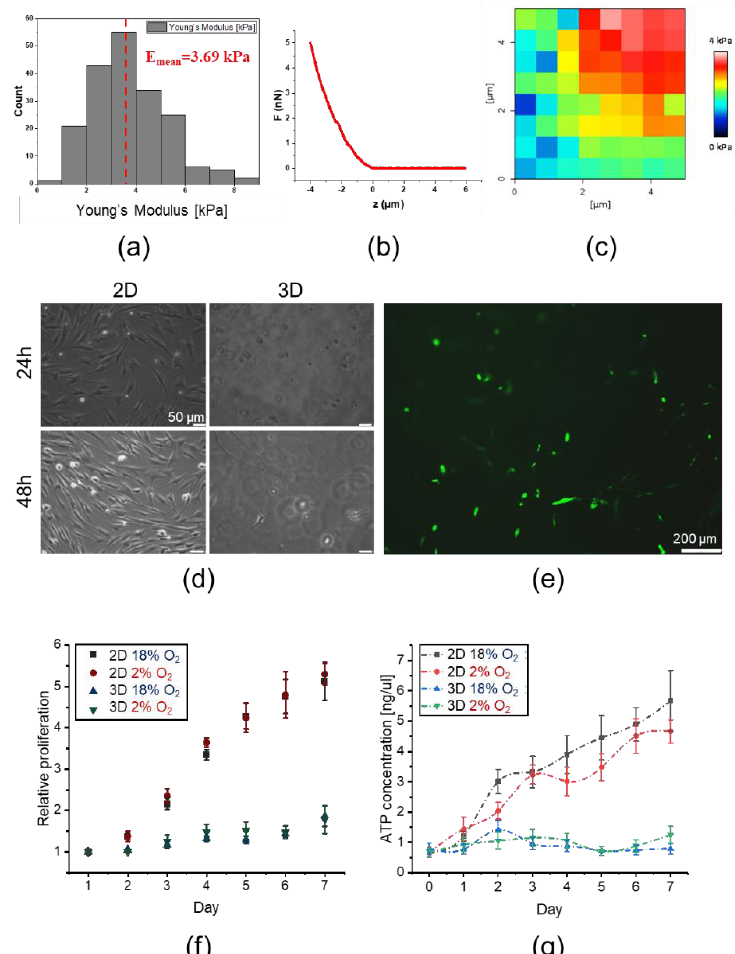
Figure 7. Mechanical properties of the hydrogel matrix and their impact on morphology, proliferation, and metabolic activity of DPSCs. ( a ) Young’s modulus distributions of hydrogel matrix by AFM. ( b ) Exemplary force curve recorded on the hydrogel. ( c ) Exemplary elasticity map of peptide hydrogel. ( d ) Morphology of DPSCs encapsulated in hydrogel (3D) or seeded on the surfaces coated with gelatin (2D) at 24 and 48 h post-seeding. DPSCs were cultured in DMEM / F12 supplemented with 10% FBS and cultured under standard culture conditions (5% CO 2 , normoxia). ( e ) Morphology of DPSCs encapsulated in hydrogel (3D culture) on day 4 post-seeding. Cells were stained with fluorescein diacetate and analysed with Leica DMI6000B ver. AF7000 fluorescent microscope to visualize their morphology. ( f ) The proliferation of DPSCs in 2D and 3D cultures in the environment containing about